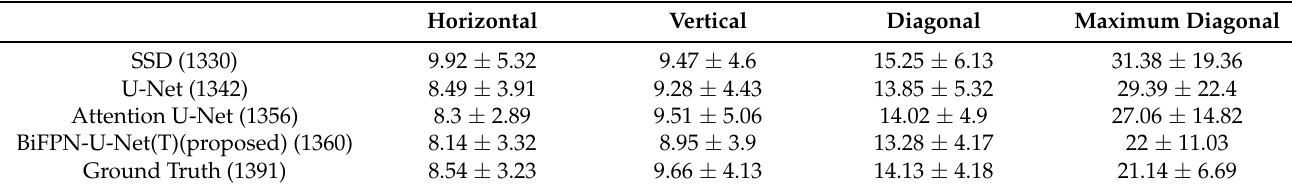
Table 3. Estimated distance of hyoid bone movement.